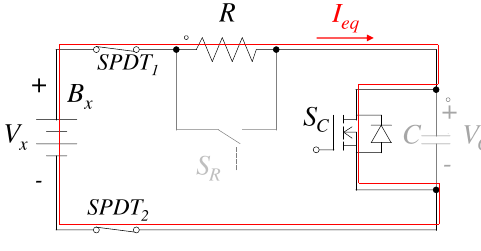
Figure 4. Resistor-based mode of